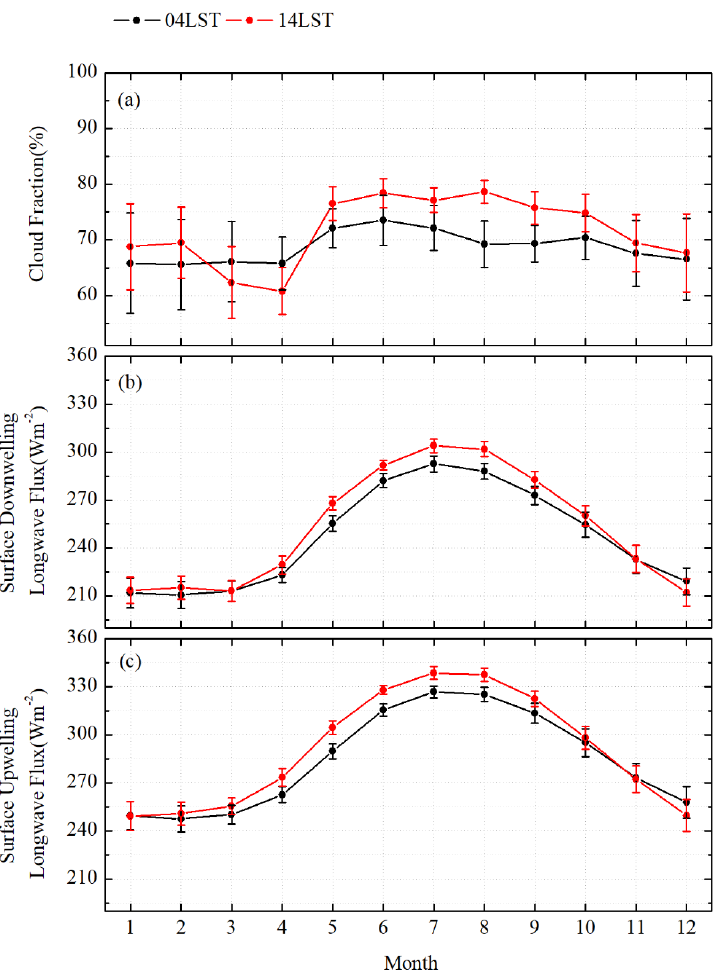
Figure 2. Seasonal variations of ( a ) CF, ( b ) DLF, and ( c ) ULF averaged over the seas in Arctic from 60°N to 90°N from 1982 to 2019 at 04:00 LST (black) and 14:00 LST (red). Bars represent ± standard deviation of the mean.